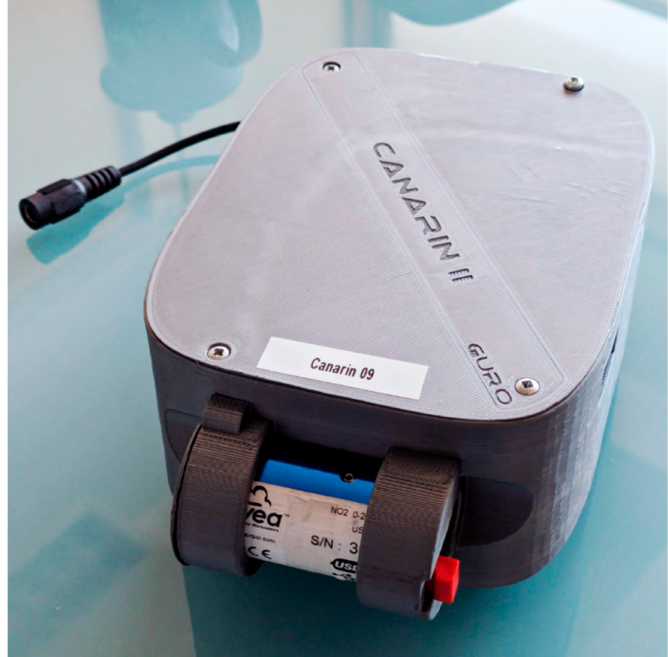
Figure 2. Canarin II in grey. The Cairsens NO 2 is conveniently attached to